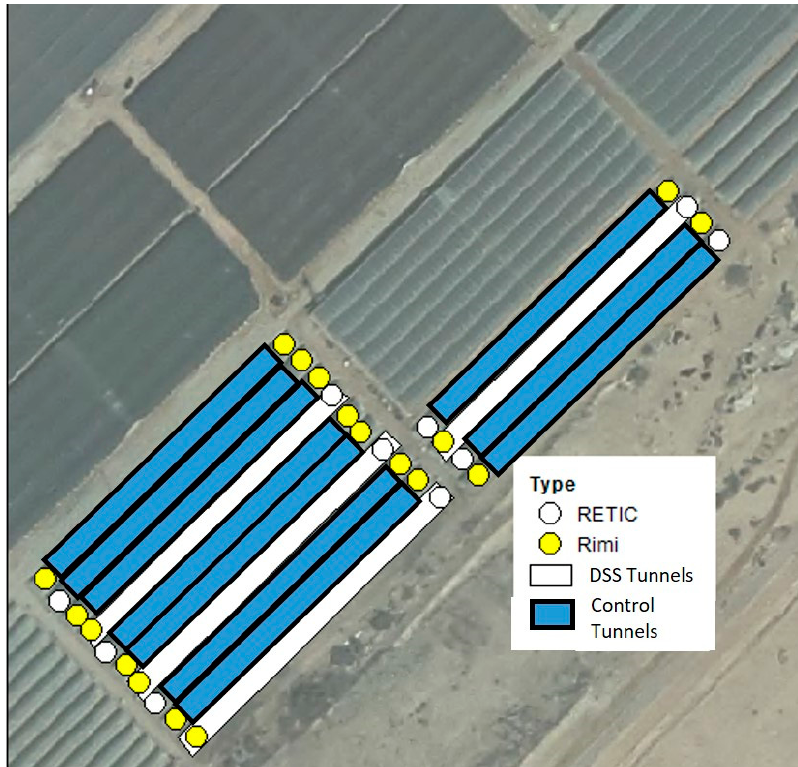
Figure 5. Aerial image of the southern melon growing area site in Ein Yahav used during the decision support system (DSS) management of the Ethiopian fruit fly in 2015. Strips show the position of parallel plastic greenhouses. White strips (4) were those greenhouses used for DSS-management. Blue strips (10) with melon production were used as control greenhouses (i.e., management by calendar-spraying of the pesticide). Yellow and white dots show the position of Rimi ® yellow sticky boards (yellow dots), and real-time wireless trapping system (white dots, RETIC) used to monitor the Ethiopian fruit fly. Monitoring systems were placed in the entrances of greenhouses where melons were grown. Only those strips flanked by either yellow or white dots produced melons during the spring of 2015 in the southern site of Ein Yahav.